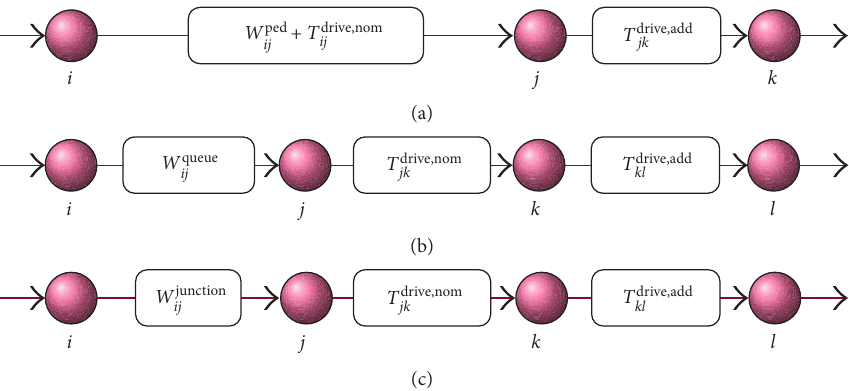
Figure 8: Network representations of the three versions of the driving module: (a) a general driving section, (b) the first driving section after generation, and (c) a junction. All start with waiting time, then a nominal driving time (for a general driving section, these are combined into